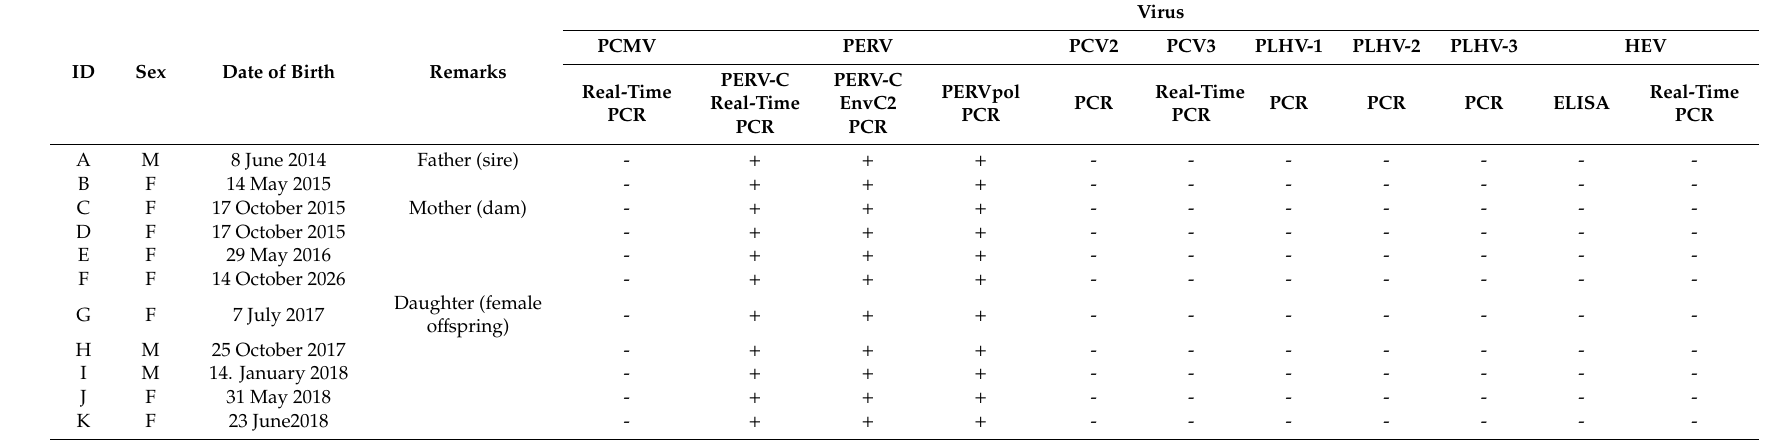
Table 1. Overview of the screening of Göttingen Minipigs from the University Göttingen (blood was taken on 8 February 2019 and 1 March 2019, and for some